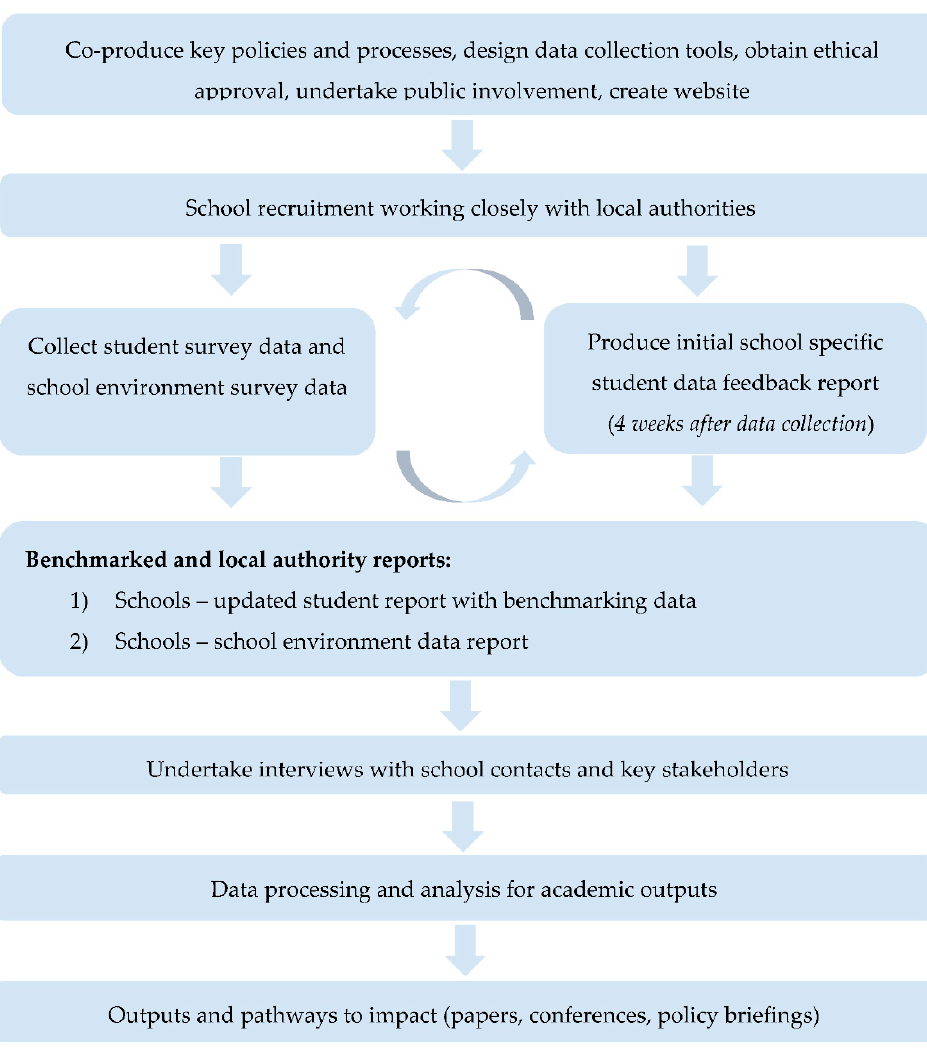
Figure 2. SW-SHRN Procedural Overview .